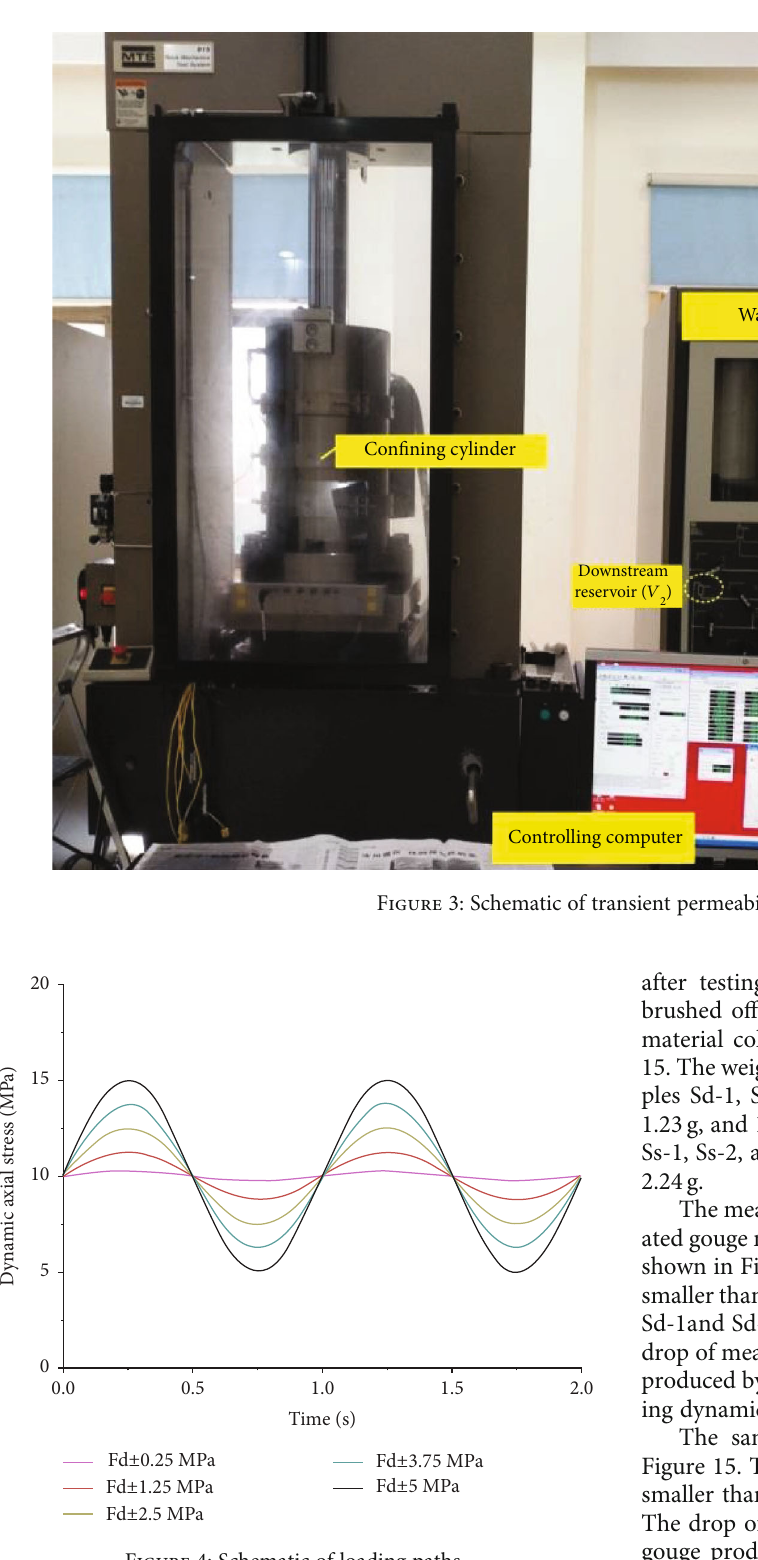
Figure 4: Schematic of loading